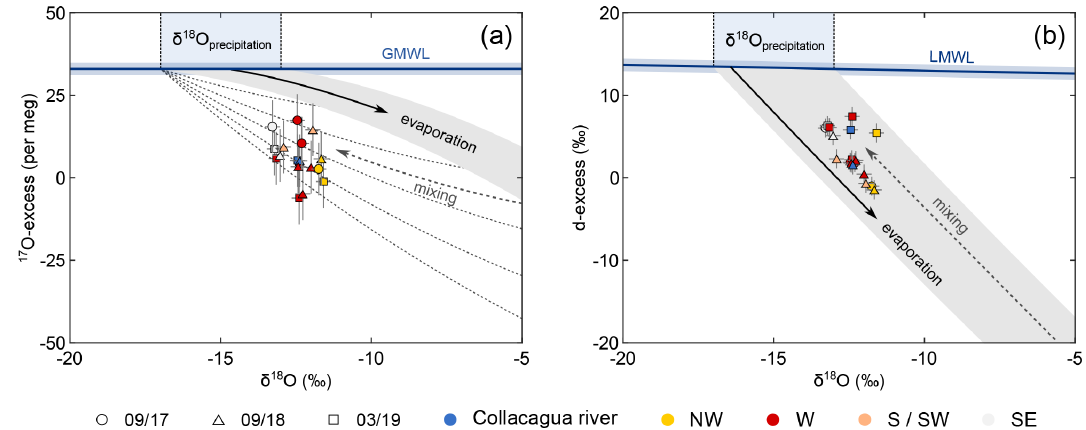
Figure 10. Oxygen (a) and hydrogen (b) isotopic data of the Collacagua river and springs from the Salar del Huasco basin. Colour coding refers to different hydrological subsystems (cf. Fig. 2). The isotopic range of precipitation ( − 17‰ to − 13‰) is derived from previously published data (Scheihing et al., 2018, and references therein). The local meteoric water line (LMWL: δ 2 H = 7 . 93 · δ 18 O + 12.3; Boschetti et al., 2019) was derived from precipitation data of northern Chile. Due to the lack of a comprehensive dataset of 17 O in precipitation, the global meteoric water line (GMWL) was used as reference in the triple oxygen isotope plot (a) . The shaded grey area indicates the isotopic evolution of precipitation undergoing evaporation. The Collacagua river and all local springs fall below the common evaporation trend in a plot of 17 O-excess over δ 18 O (a) . This offset can be explained considering mixing of precipitation with evaporated water in the vadose zone during infiltration into the soil. The effect of mixing is schematically illustrated by the dashed grey